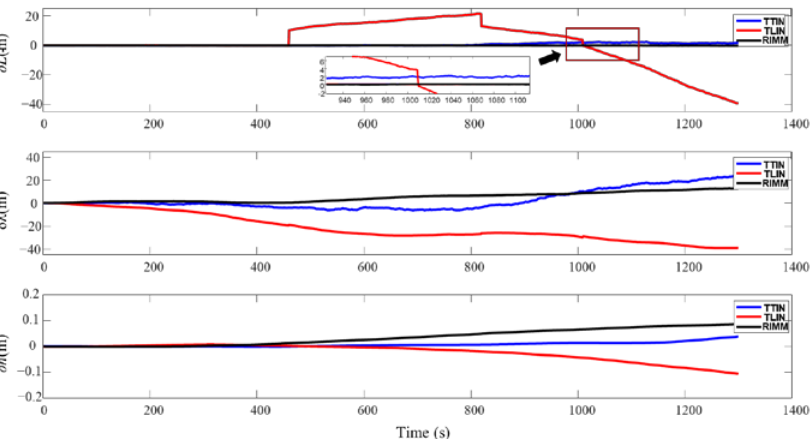
Figure 12. Position errors of three algorithms when DVL works in a complex e nvironment. Table 6. Position error parameters for the three algorithms when DVL w orks in a c omplex e nvi- ronment.